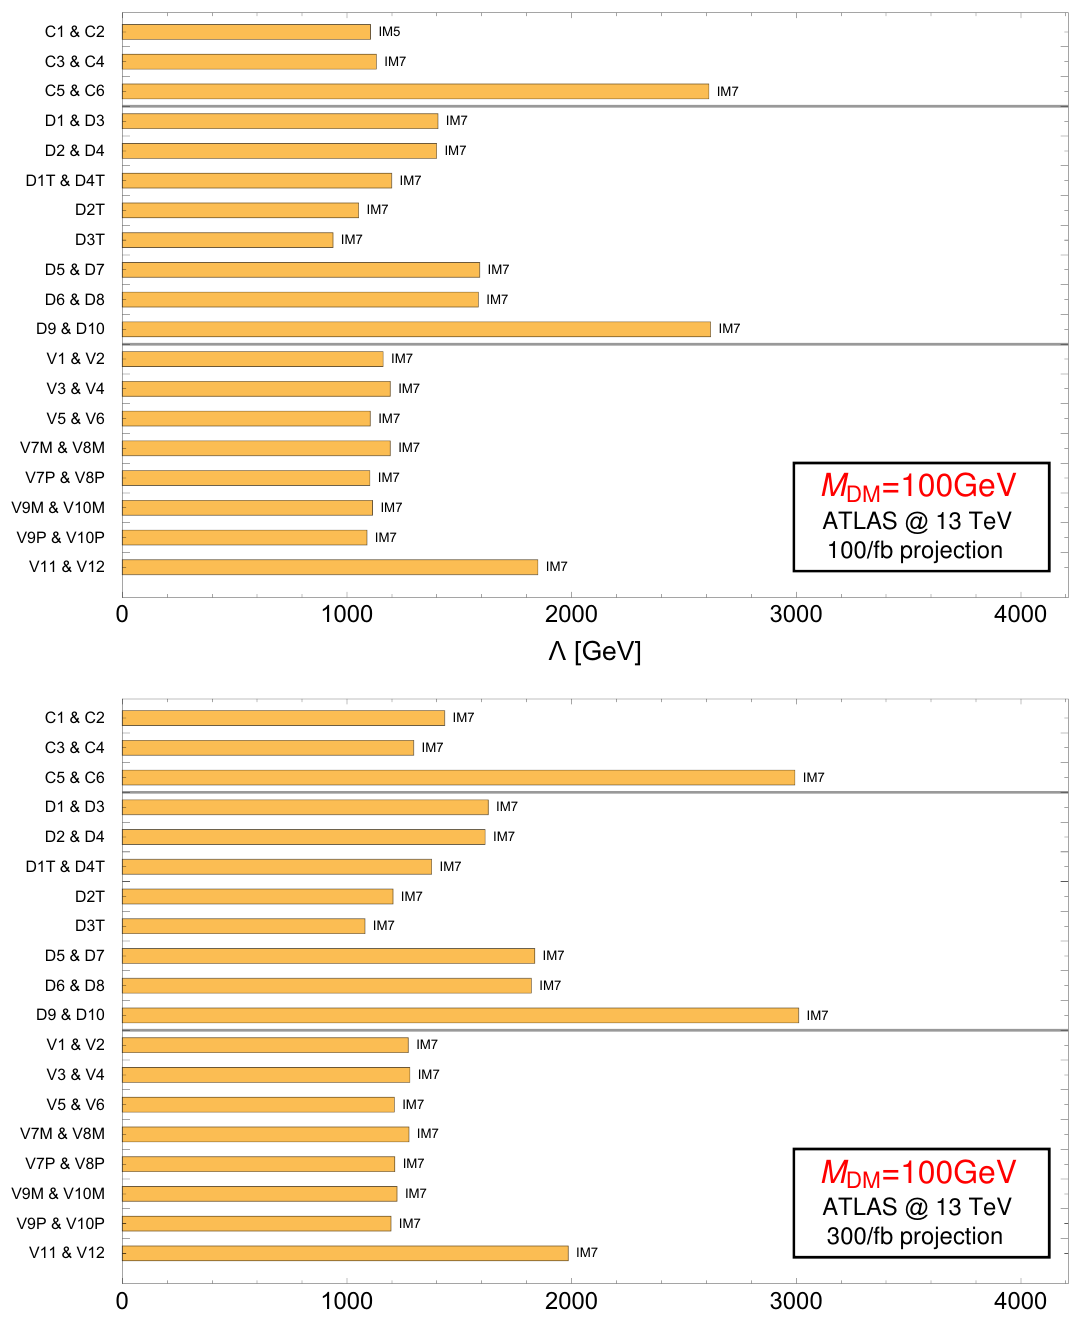
Λ [ GeV ] Figure 11 . Expected limits on the UV cut-o(cid:11) (cid:3) considering the selection of the ATLAS search of ref. [3] and re-scaling to luminosities of 100 fb (cid:0) 1 (top panel) and 300 fb (cid:0) 1 (bottom panel). The exclusion values of (cid:3) correspond to the assumptions that the background scales linearly with the luminosity and that the number of observed events matches the background (expected limit).